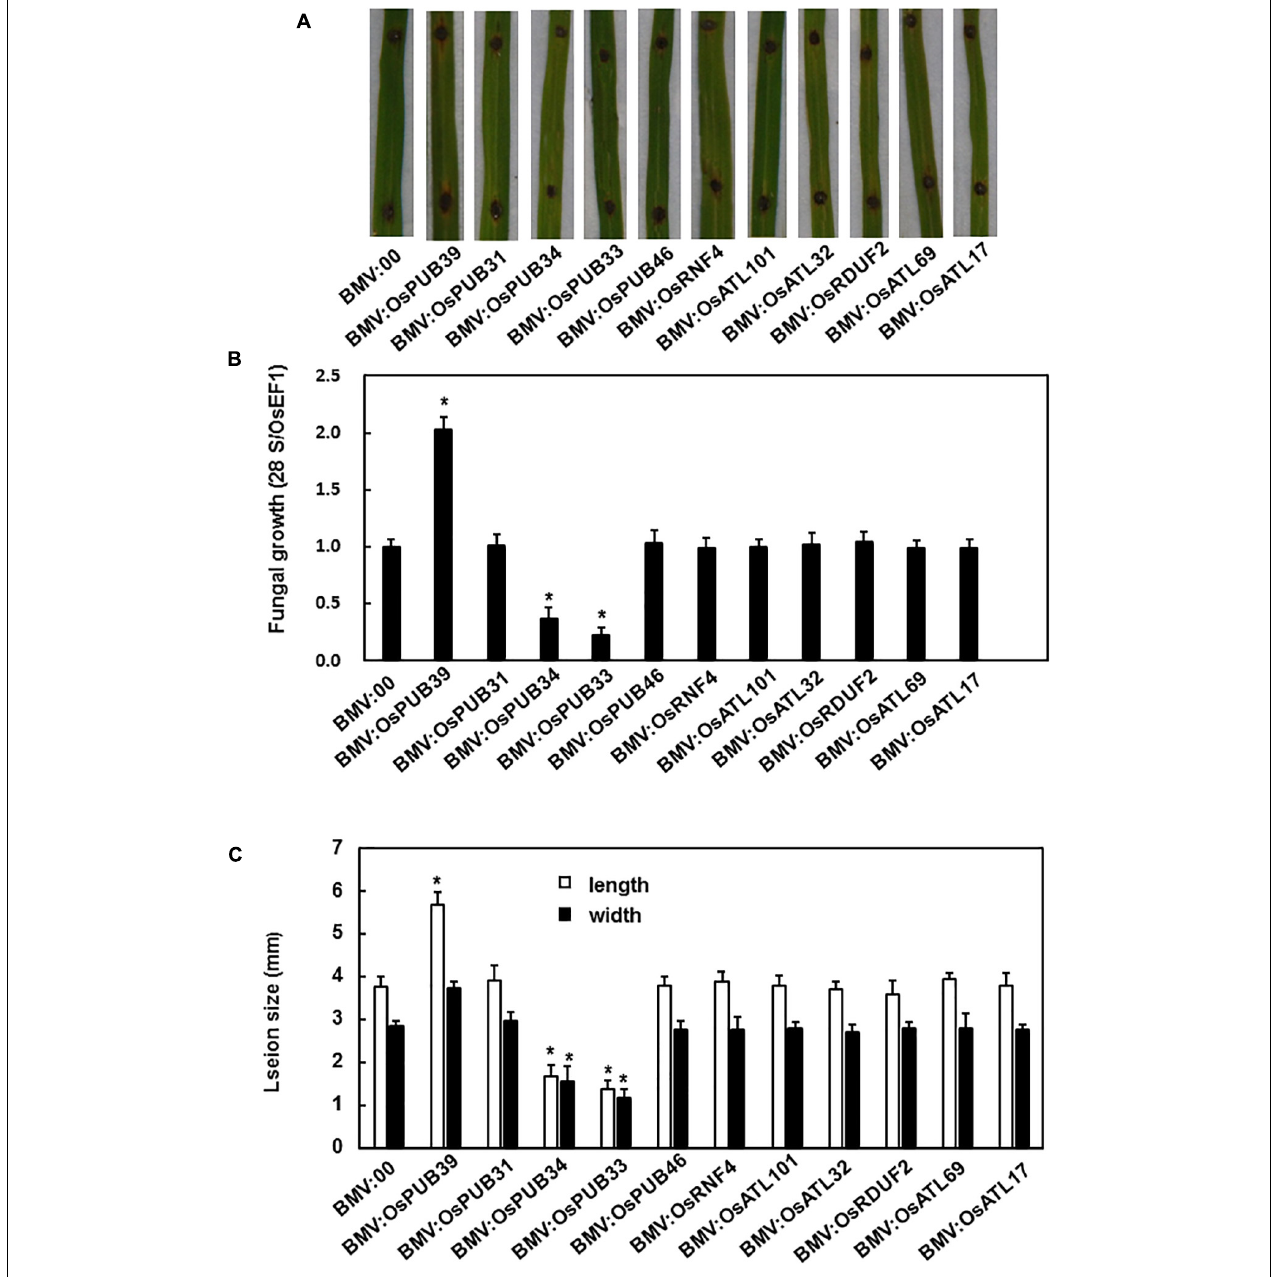
FIGURE 3 | BMV:OsPUB34- and BMV:OsPUB33-infiltrated seedlings showed significantly increased resistance to M. grisea when compared with the control, whereas BMV:OsPUB39-infiltrated seedlings showed decreased resistance to M. oryzae . (A) The lesions on the rice leaves 7 days after inoculation. (B) The quantities of bacteria in leaves of BMV:target gene- and BMV:00-infiltrated seedlings. (C) The length and width of the lesions on BMV:target gene- and BMV:00-infiltrated seedlings. *Above the columns indicate significant differences between BMV:target gene- and BMV:00-infiltrated seedlings at p < 0.05